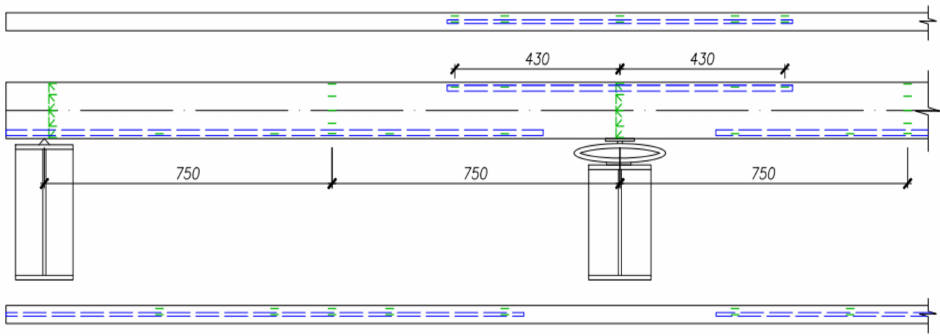
Figure 3. The locations of the strain gauges on the beam. Values are expressed in